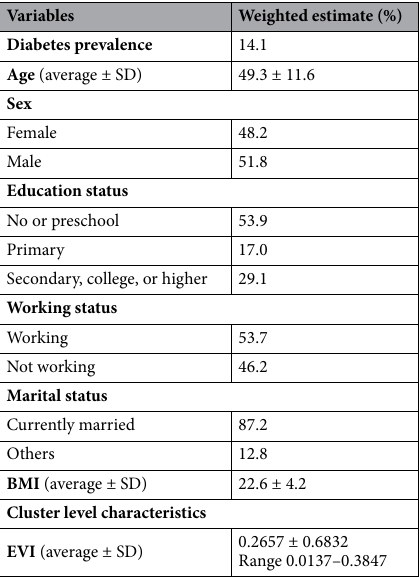
Table 1. Descriptive statistics of the analytic sample. SD standard deviation, BMI body mass index, EVI enhanced vegetation index.